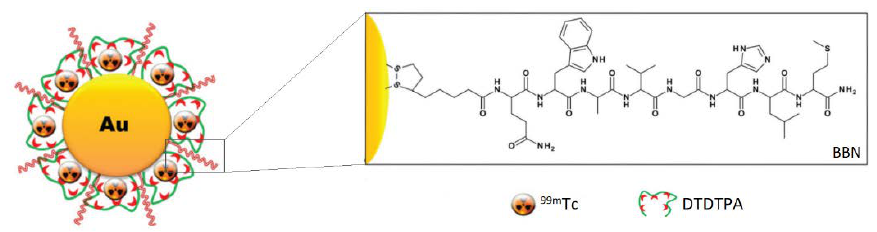
Figure 10. Structure of 99m Tc-labeled gold nanoparticles conjugated with BBN and DTDTPA. Adapted with permission from ref. [27]. Copyright 2022, Royal Society of Chemistry.